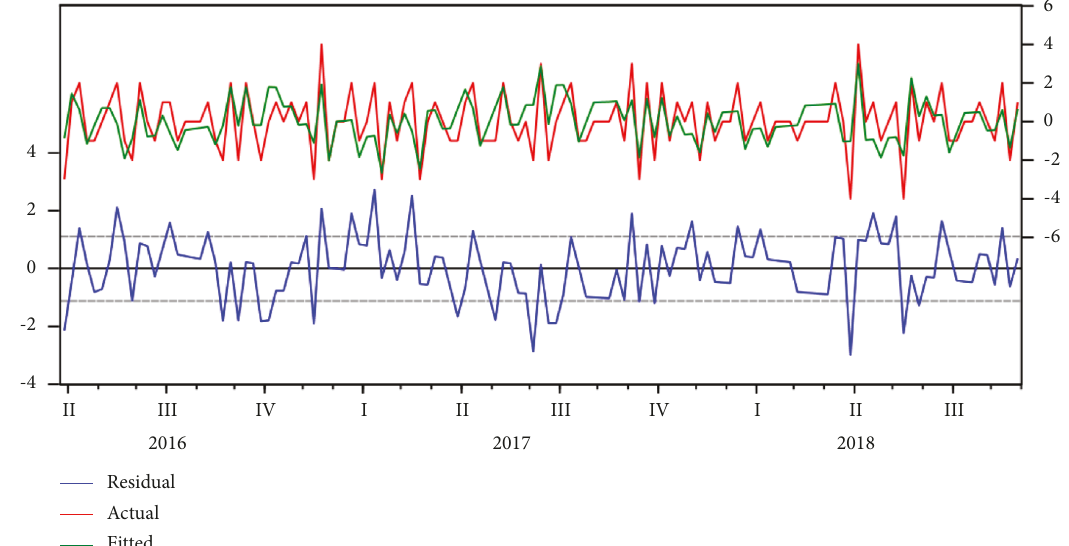
Figure 1: Forecasts for the first difference of customer 6.